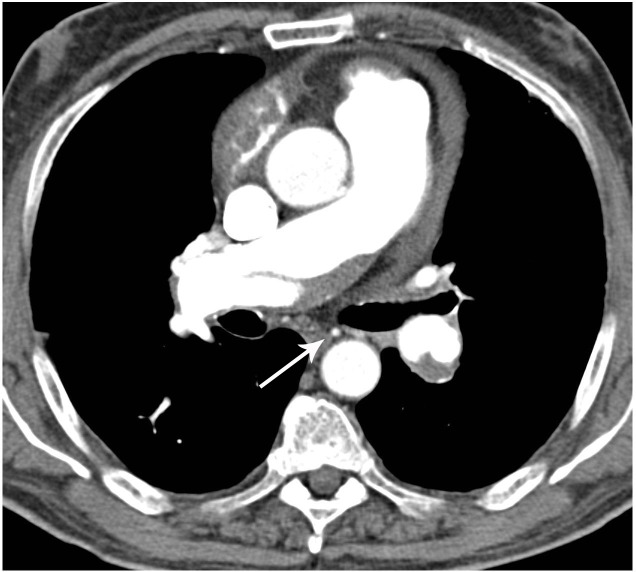
Bronchial collateral arteries in patients with CTEPH.Axial MDCTA image shows bronchial collateral arteries (arrow) in a patient with wall-adherent intraluminal thrombi in the right pulmonary artery and left lower lobe artery.